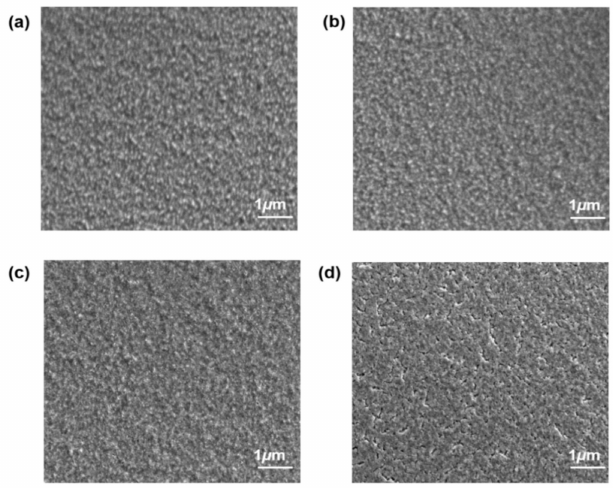
Figure 2. SEM images of ETL with ( a ) TiO 2 ( b ) 0.1 ( c ) 0.2 and ( d ) 0.3 proportions of SnO 2 .